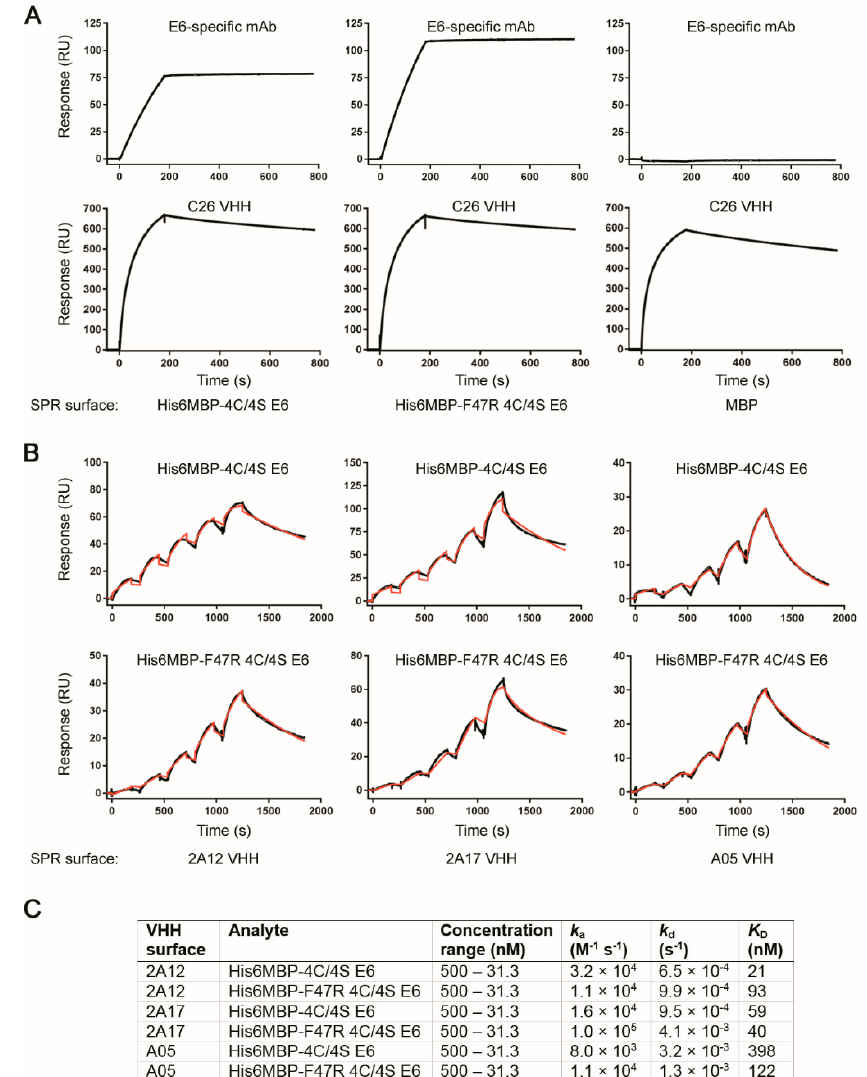
Figure 5. Surface plasmon resonance (SPR) binding assays demonstrating the interaction of the His6MBP-F47R 4C/4S E6 and His6MBP-4C/4S E6 proteins and VHHs. ( A ) SPR surfaces with His6MBP-F47R 4C/4S E6, His6MBP-4C/4S E6 or control MBP (His6MBP-intimin) were created and VHHs or mAbs flowed over. The HPV16 E6-specific 6F4 mAb bound E6-containing surfaces and not the MBP control surface while the C26 VHH bound all MBP-containing surfaces. All other VHHs tested did not bind any surface (data not shown). ( B ) VHHs were immobilized and SEC-purified His6MBP-F47R 4C/4S E6 or His6MBP-4C/4S E6 proteins flowed over using single-cycle kinetics to determine affinities and kinetics. Black lines represent raw data and red lines represent 1:1 binding model fits. ( C ) Summary of VHH binding affinities calculated from the sensorgrams in ( B ).